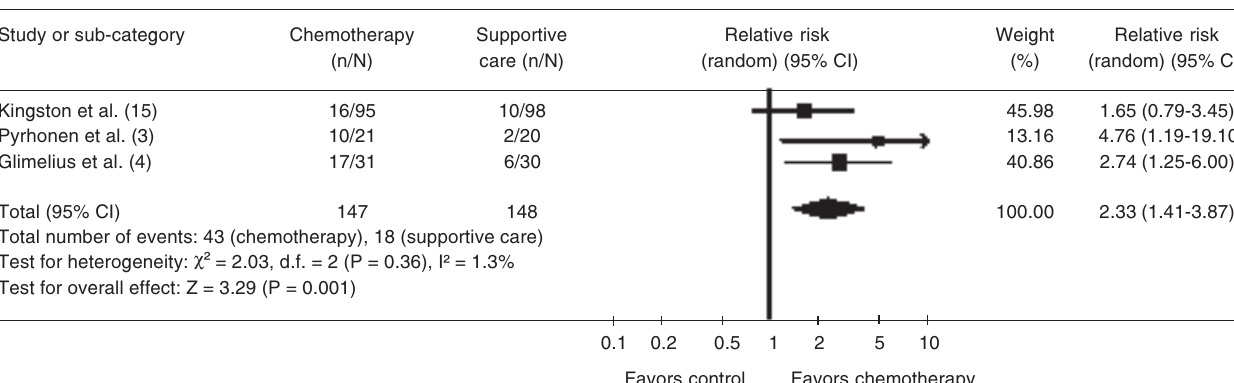
Review: Chemotherapy versus support care treatment in advanced gastric cancer: a meta-analysis Comparison: 1 chemotherapy versus supportive care treatment Outcome: 3 symptom-free